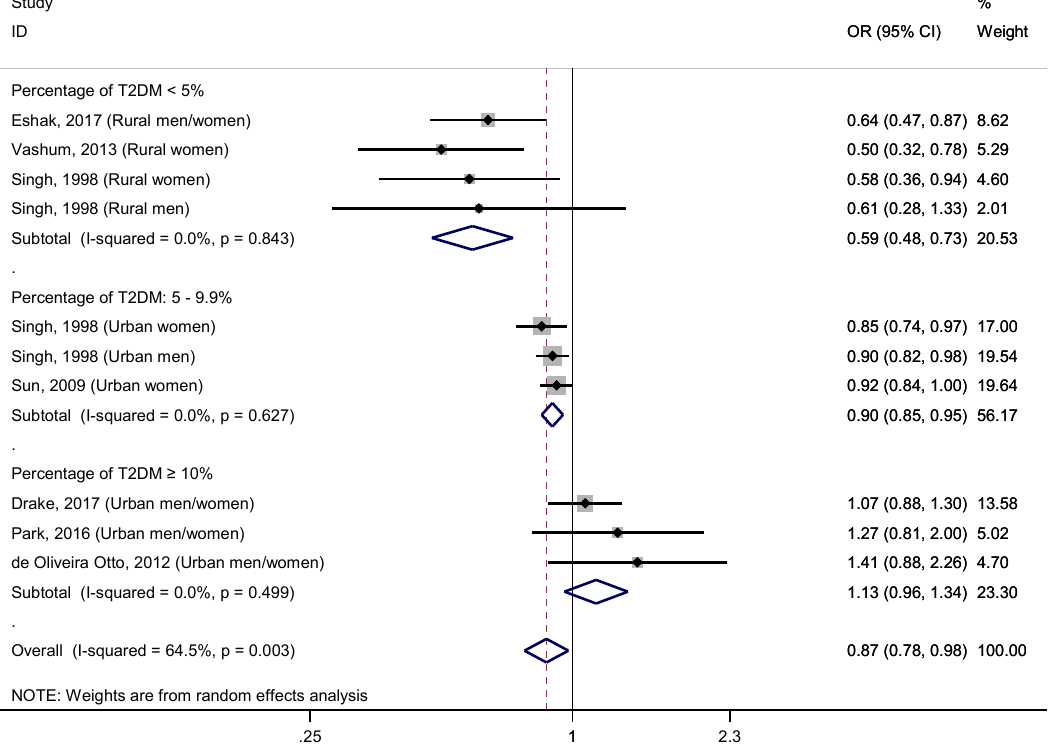
Figure 5. Forest plot of pooled effect size of the highest vs. lowest dietary zinc intake for T2DM according to the percentage of T2DM ( < 5% / 5–9.9% / ≥ 10%). Squares represent ORs for each study, and the size of the square is the study-specific statistical weight. Horizontal lines indicate the 95% CI of each study. Diamond represents the combined OR estimate with corresponding 95% CI.